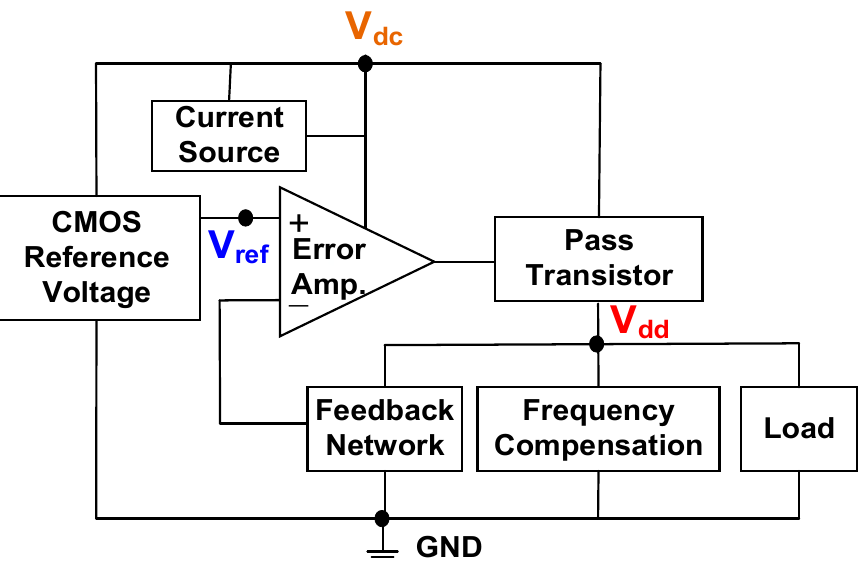
Figure 5. Proposed low-voltage LDO regulator with a reference voltage, a current source, an error amplifier, a pass transistor, a feedback network, frequency compensation, and a load.